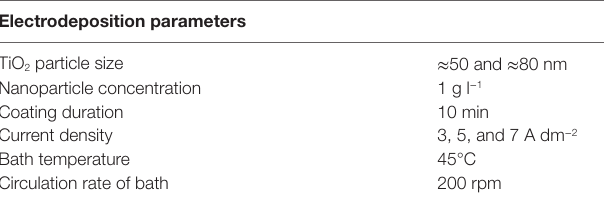
TaBle 2 | electrodeposition parameters of ni–TiO 2 nanocomposite coatings.